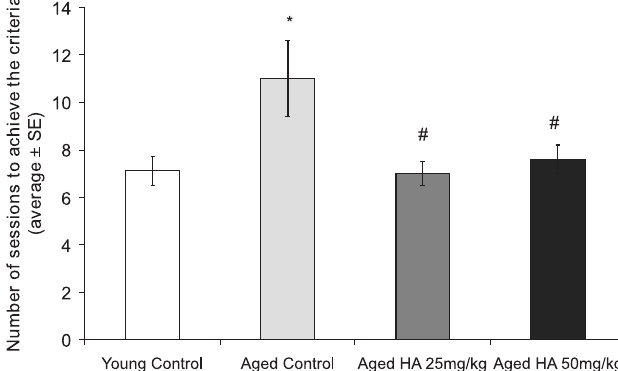
FIGURE 2 - Number of sessions required to achieve the learning criteria in the T maze by young control rats (  ), aged control rats (  ) and aged rats treated with 25 mg/kg (  ) or 50 mg/kg (  ) of Heteropterys aphrodisiaca extract (HA) for 45 days. The values are expressed as mean ± standard error. *Statistically different from the young control group ( p <0.05). #Statistically different from the aged control group ( p <0.05). 1-ANOVA followed by